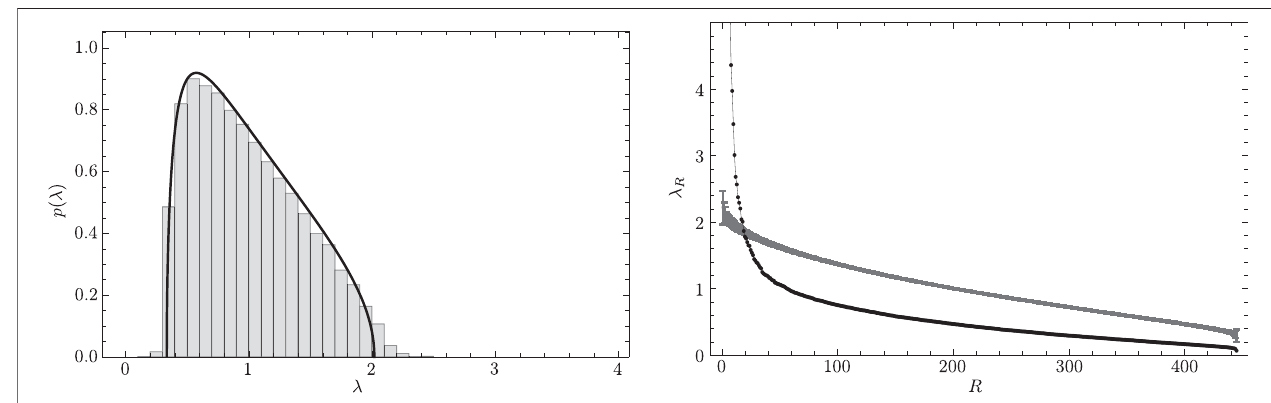
FIGURE 4 | (Left) Distribution p ( λ ) of eigenvalues λ of the equal-time cross-correlation matrix constructed by rotational random shuf fl ing (RRS). The solid line represents the Mar ˇ cenko-Pastur distribution derived under RMT as the theoretical curve given by Eq. 5 . (Right) Scree graph of eigenvalues. The abscissa represents eigenvalue rankings R , and the ordinate represents empirically obtained eigenvalues λ R . The thin line with fi lled circles depicts the empirically obtained distribution of eigenvalues of the empirical equal-time cross-correlation matrix. The curve with error bars depicts the simulated distribution of eigenvalues using RRS. To obtain this curve, this manipulation was repeated 20 times, after which the mean value and standard deviation were calculated. Each error bar represents three times the standard deviation. The thin line with fi lled circles in this fi gure depicts the distribution of eigenvalues of the empirical equal-time cross-correlation matrix. The meaningful part can be obtained by comparing these two distributions. If the upper bound for eigenvalues derived from the RRS cross-correlation matrix is denoted as λ max , then